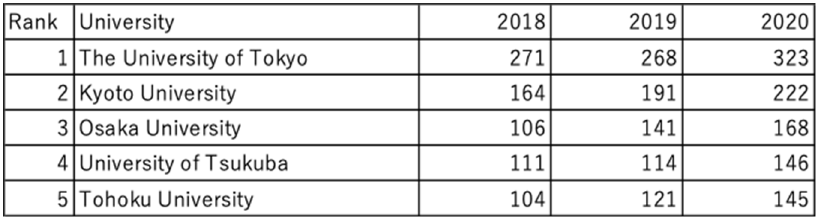
Table 1. Number of startups by universities in